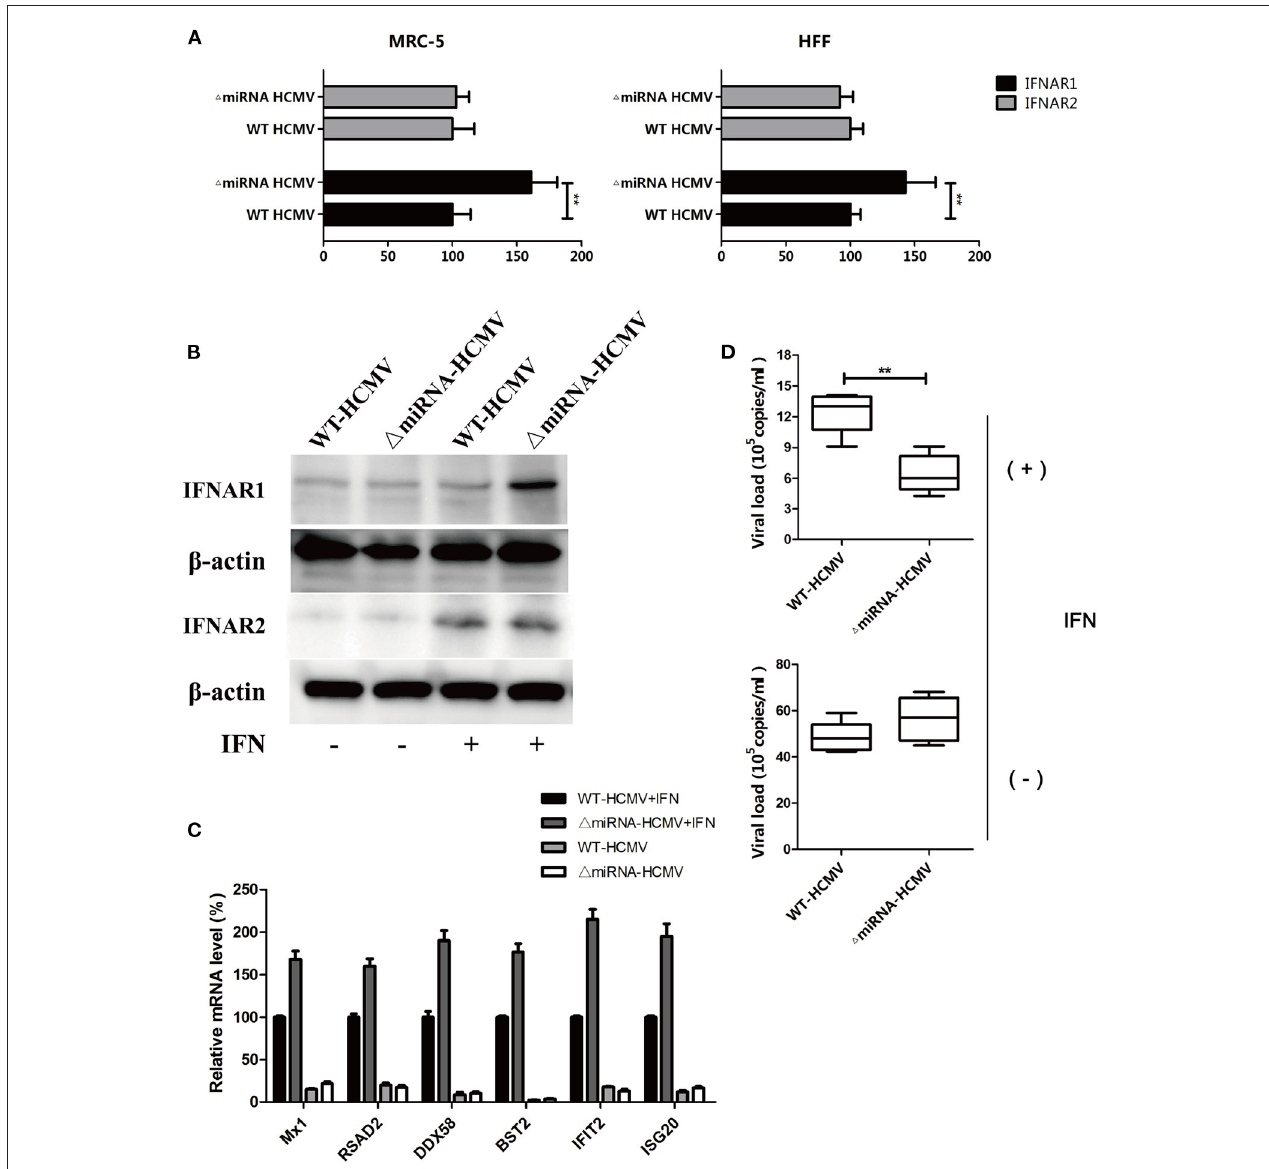
FIGURE 6 | Knockout of hcmv-US33as-5p alleviated blockade of the IFN pathway. (A,B) MRC-5 and HFF cells were infected with WT or 1 miRNA HCMV for 48h, followed by treatment with CHX and stimulation with IFN for 24h. The expression of IFNAR1 and IFNAR2 was determined by qPCR and western blot. (C) The expression of multiple ISGs was examined by qPCR. (D) Total DNA was isolated from the supernatants, and HCMV copy numbers were determined and calculated by qPCR. ** p < 0.05.